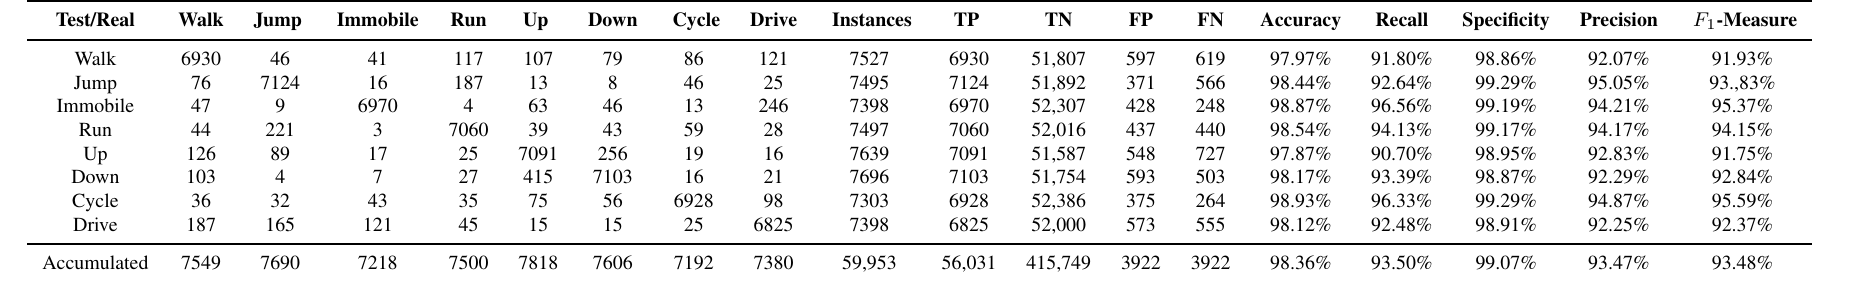
Table B2. Confusion matrix and performance values for the ANN-based classification system.